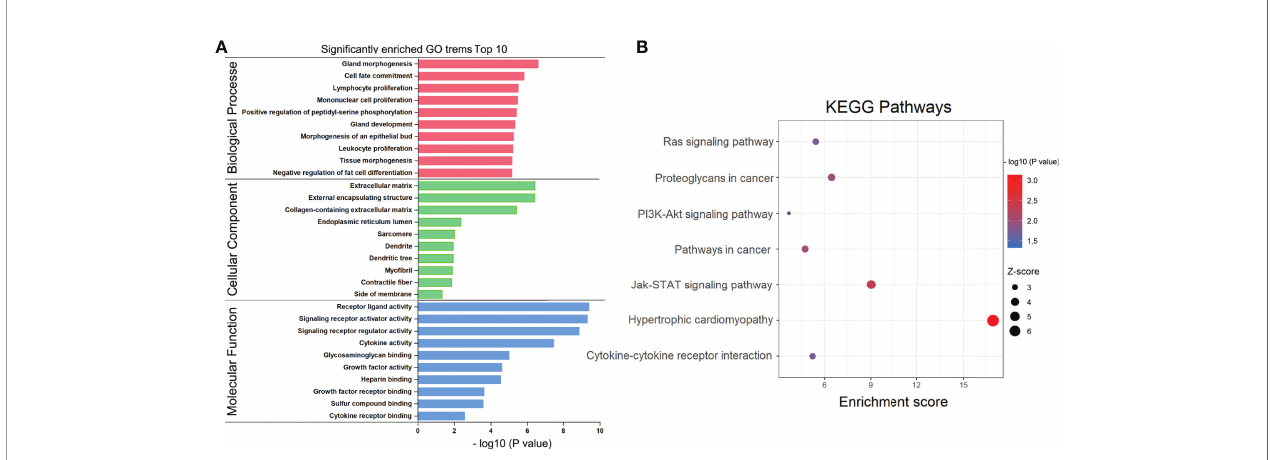
FIGURE 3 | GO and KEGG pathway enrichment analysis. (A) Bar chart of gene ontology (GO) enriched in the biological process, cellular component, and molecular function. (B) Bubble diagram of KEGG pathways enrichment